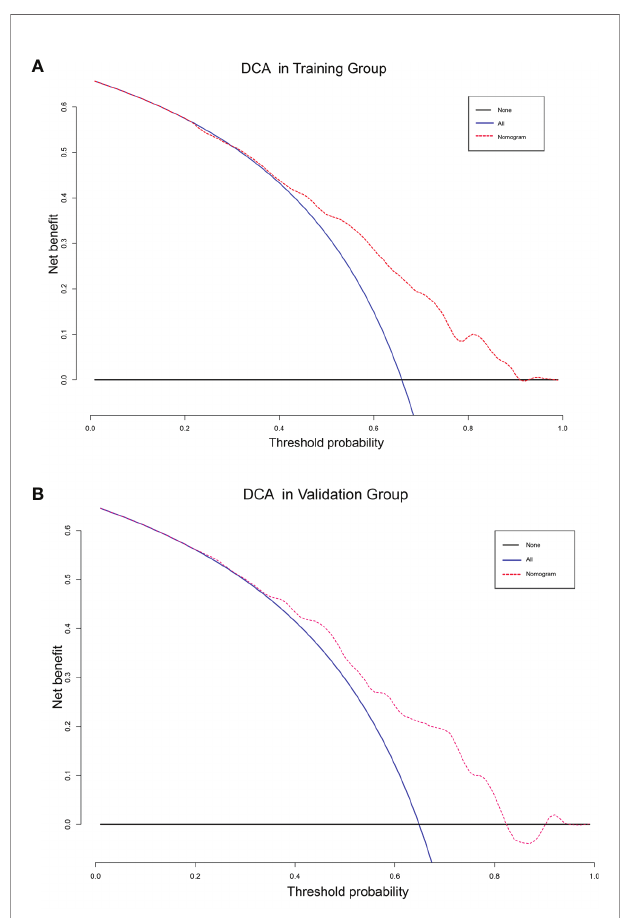
FIGURE 10 | Decision curve analysis of training group (A) and validation group (B) .